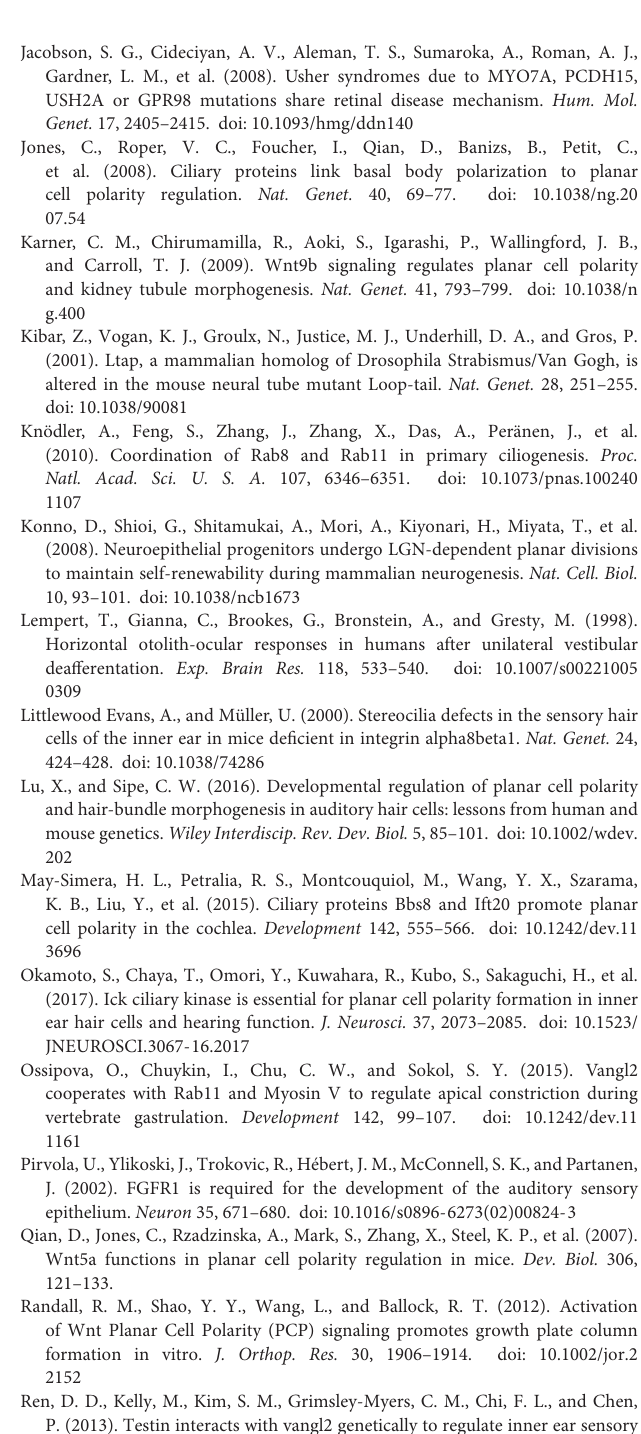
hair cells from the lateral cristae of wild-type controls. (D,D1) In Rab11a mutants, all neighboring hair cells retained the same orientation. Scale bars: 50 µ m. Supplementary Figure 4 | The Rab11a CKO / CKO utricle (A) was labeled with anti- β -spectrin (A1) , the hair cell basal body (A2) like IFT88 was labeled with anti- γ -tubulin (blue), and stereocilia bundles (A3) were labeled with phalloidin